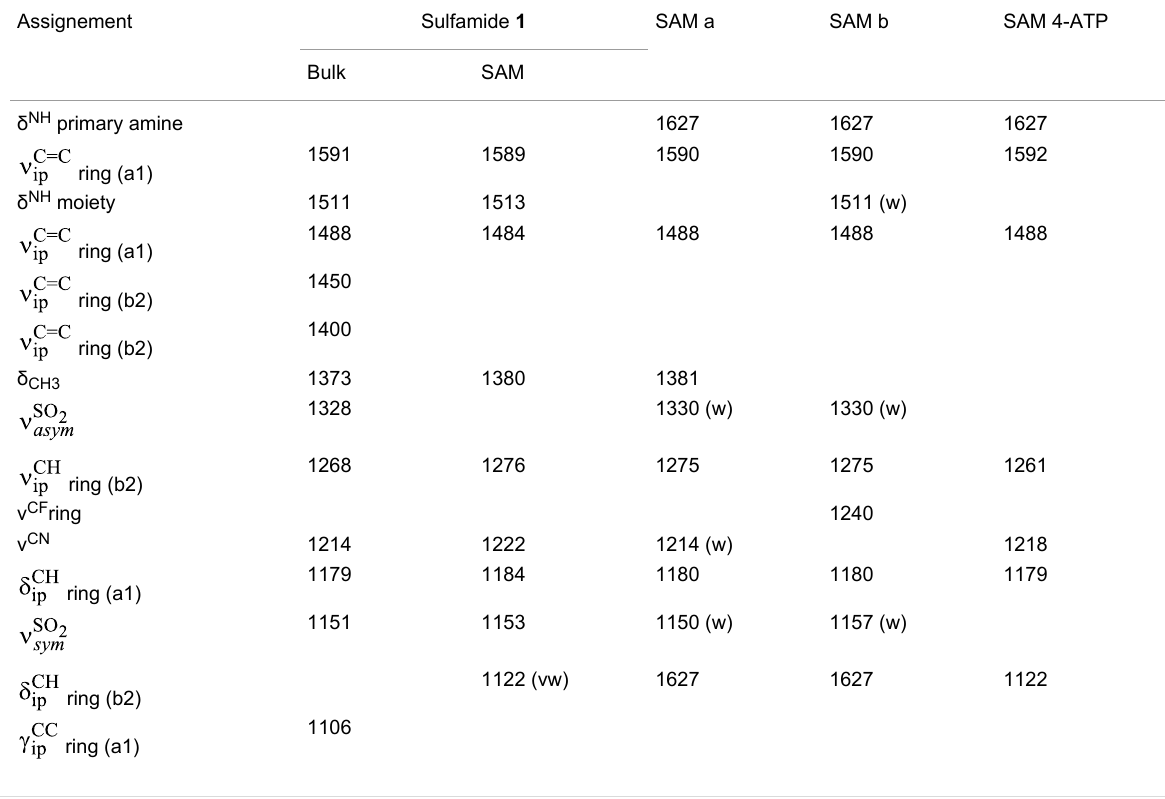
Table 1: Assignment of the vibrational modes probed by PM-IRRAS.